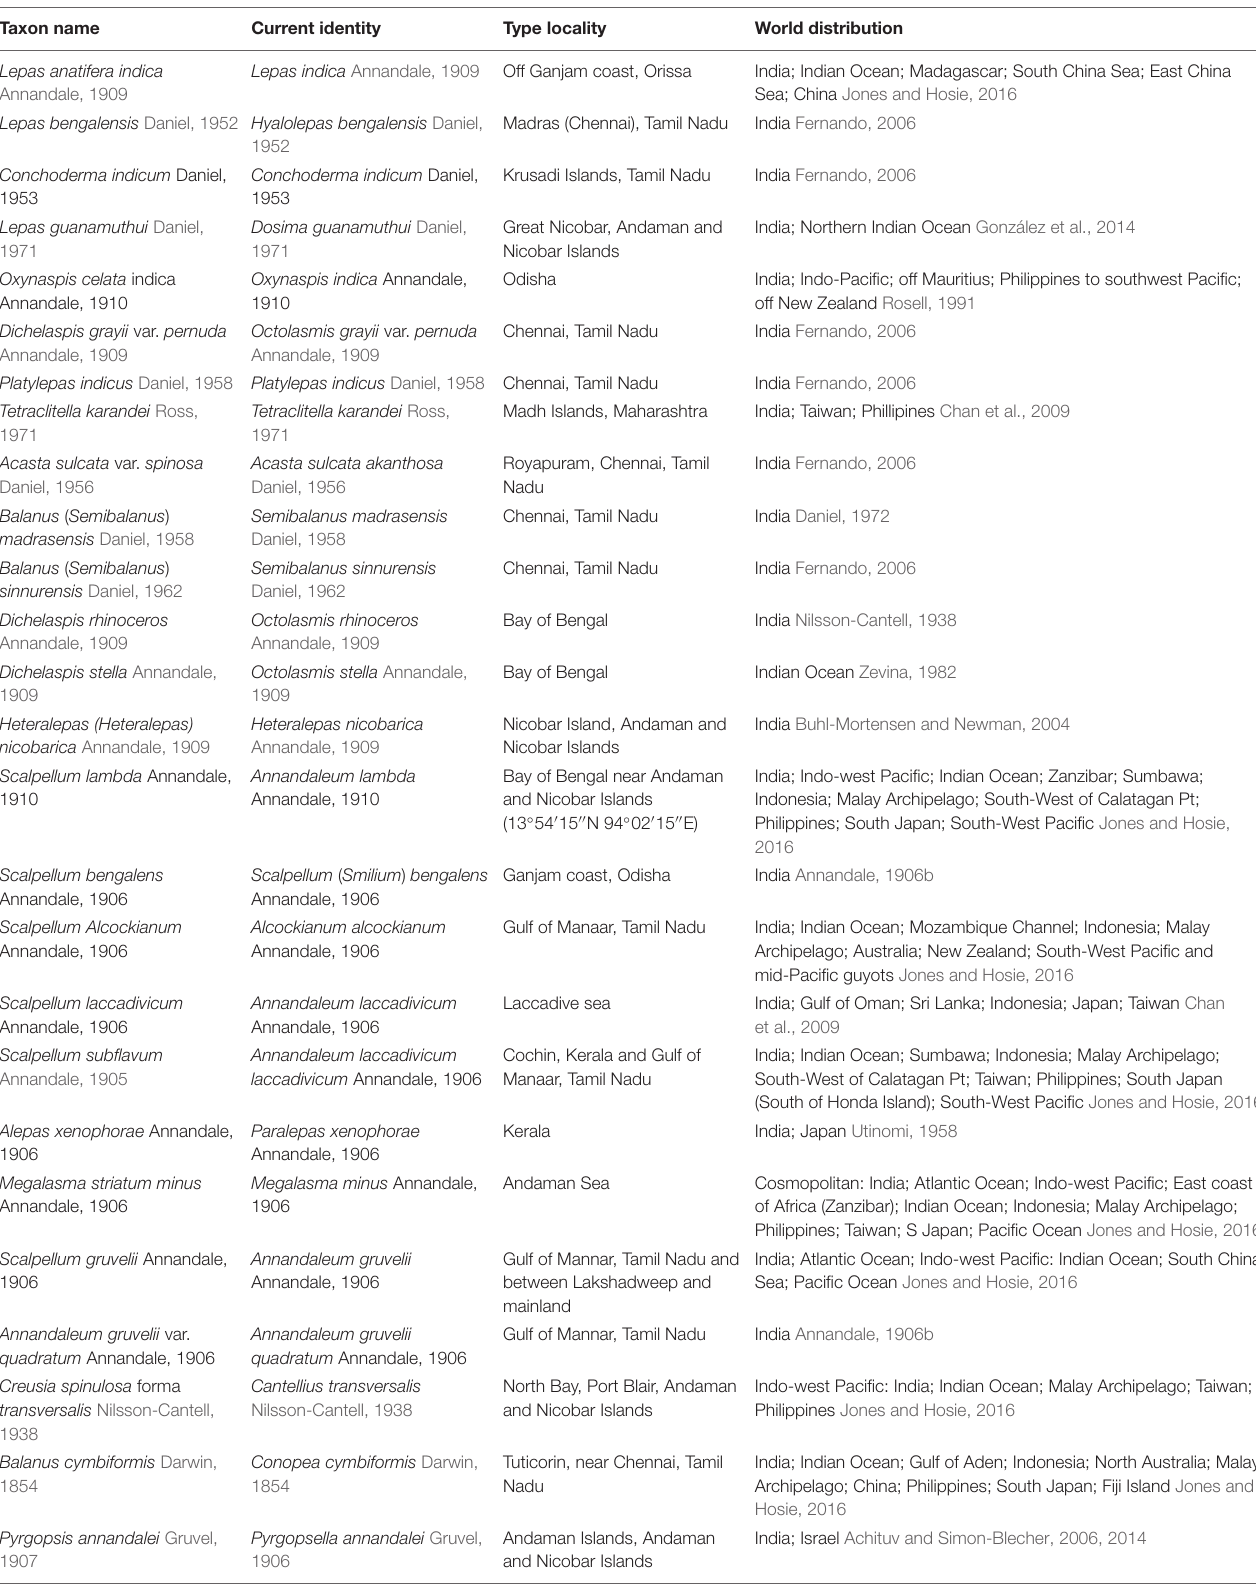
TABLE 1 | Barnacle species described from